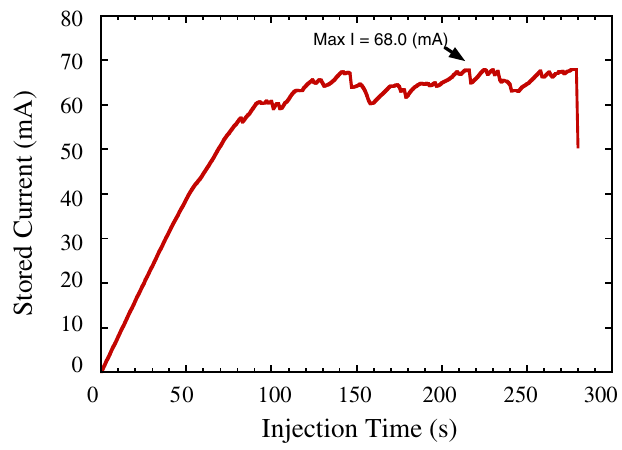
FIG. 23. (Color) Stored current when a maximum current of 68 mA is realized. Various tuning operations are required to increase the limit due to strong beam instabilities from 60 to 68 mA.